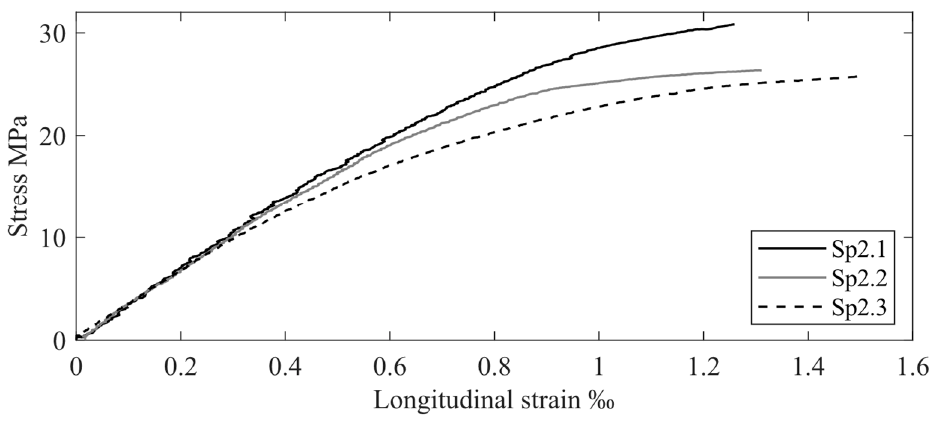
Figure 6. Experimental dependences σ c vs. ε c .